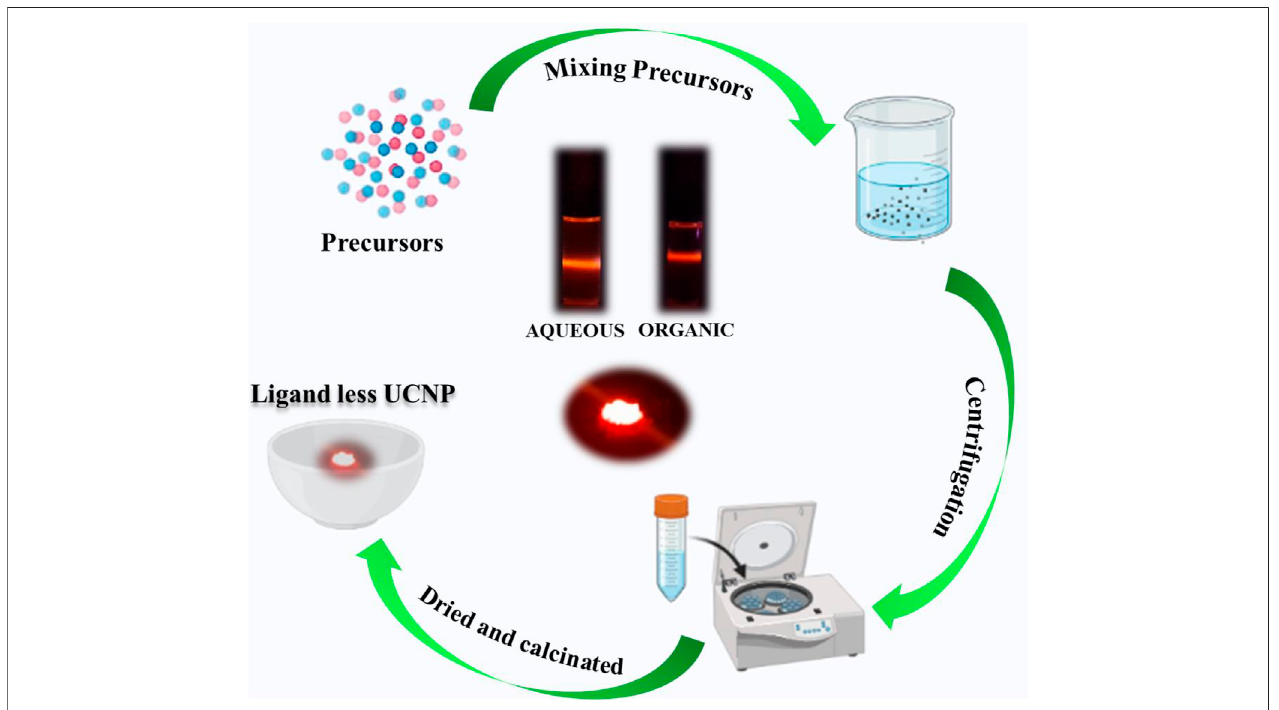
FIGURE 1 | Scheme illustrating the synthesis of ligand free